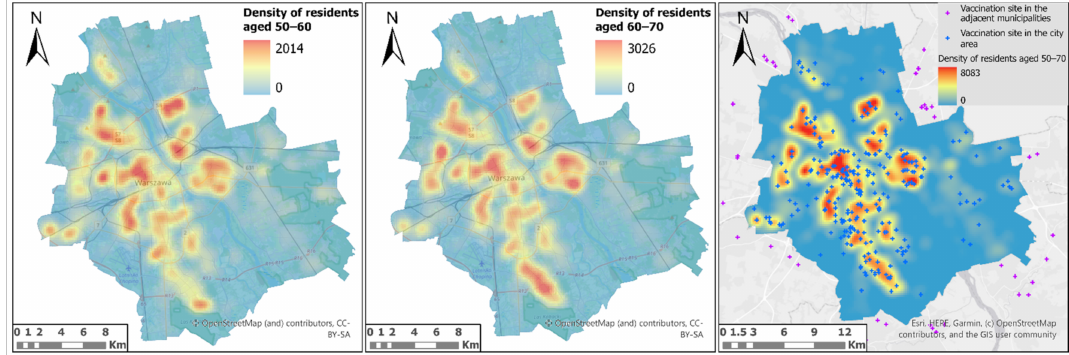
Figure 8. The distribution of hot spots of high population density in analysed age groups.